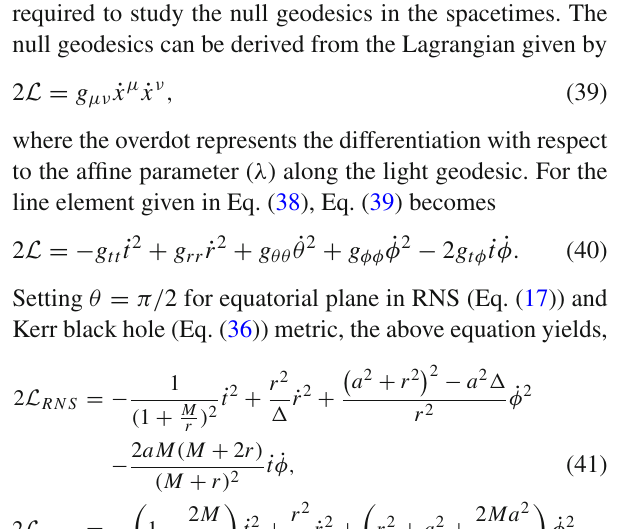
From (cid:10)( r ) = 0, we find that, the radius of horizons becomes imaginary for RNS spacetime, which indicates that it is a horizon-less compact object. The Kretschmann scalar which is defined as, k = R αβγδ R αβγδ becomes infinite in the RNS . This behaviour of the spacetime for r → 0 and θ → π 2 Kretschmann scalar indicates the presence of a ring singu- larity in the equatorial plane with a coordinate radius a . The causal structure of the RNS spacetime can be examined using the Penrose diagram. To generate the Penrose diagram, we transform the t and r coordinates into T and R coordinates, respectively, by using the following